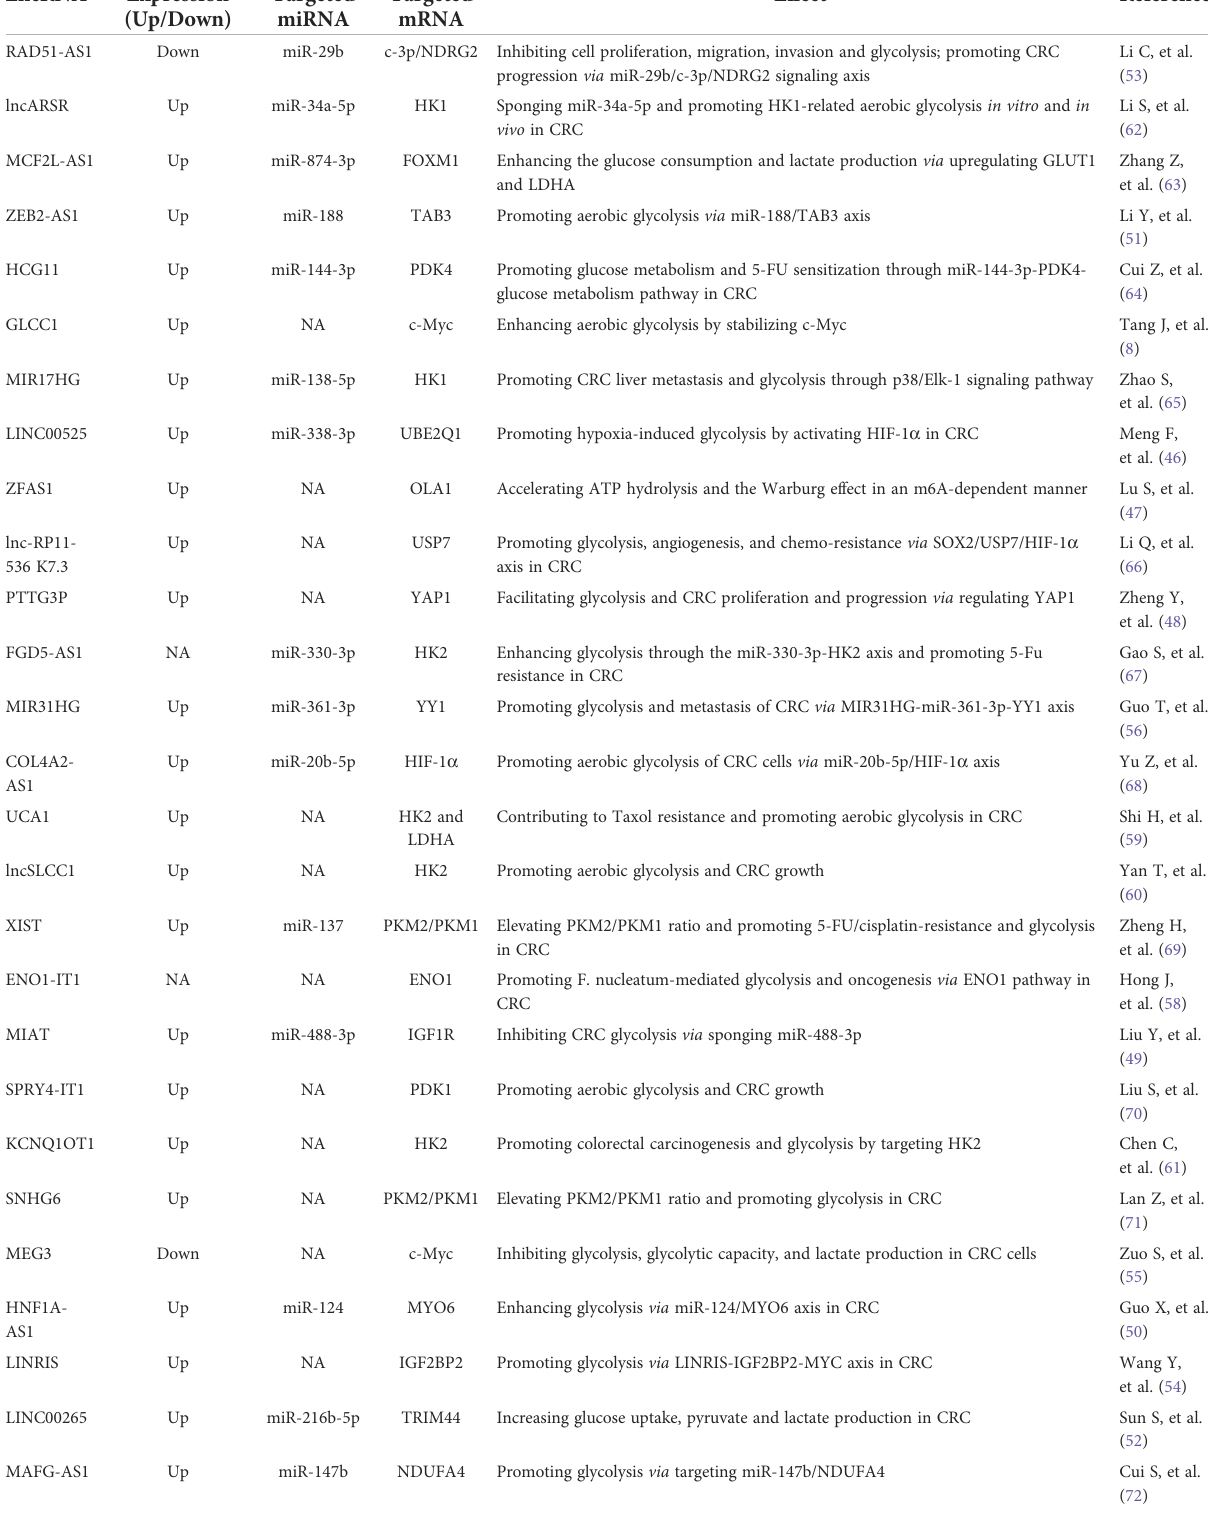
TABLE 2 LncRNAs involved in CRC glucose